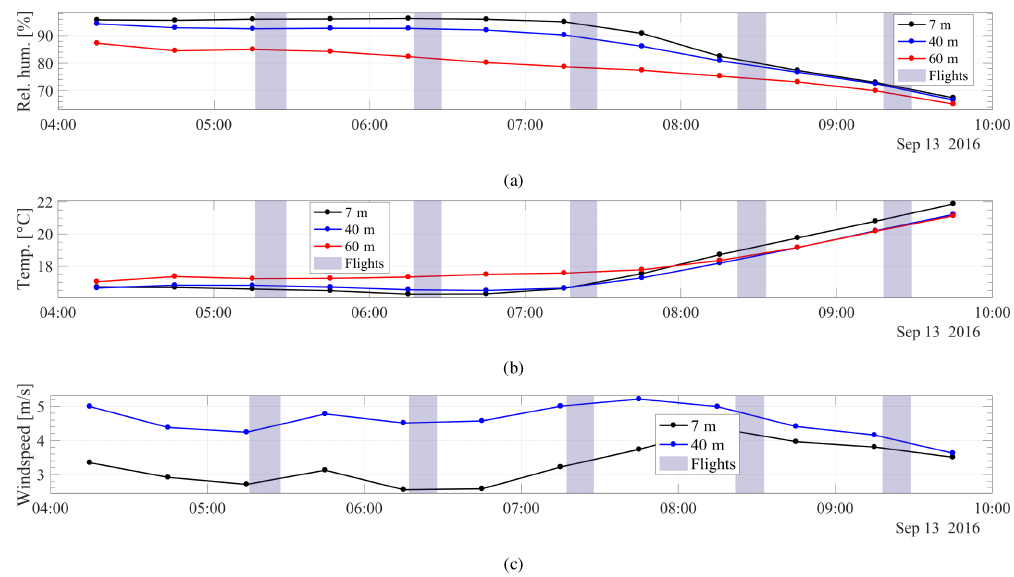
Figure 9. The meteorological data measured at the atmospheric station during 13 September 2016. Panel (a) shows the relative humidity, (b) the temperature, and (c) the wind speed. The black curve indicates measurements at 7m, the blue curve at 40m, and the red curve at 60m. The highlighted areas indicate the times of the five